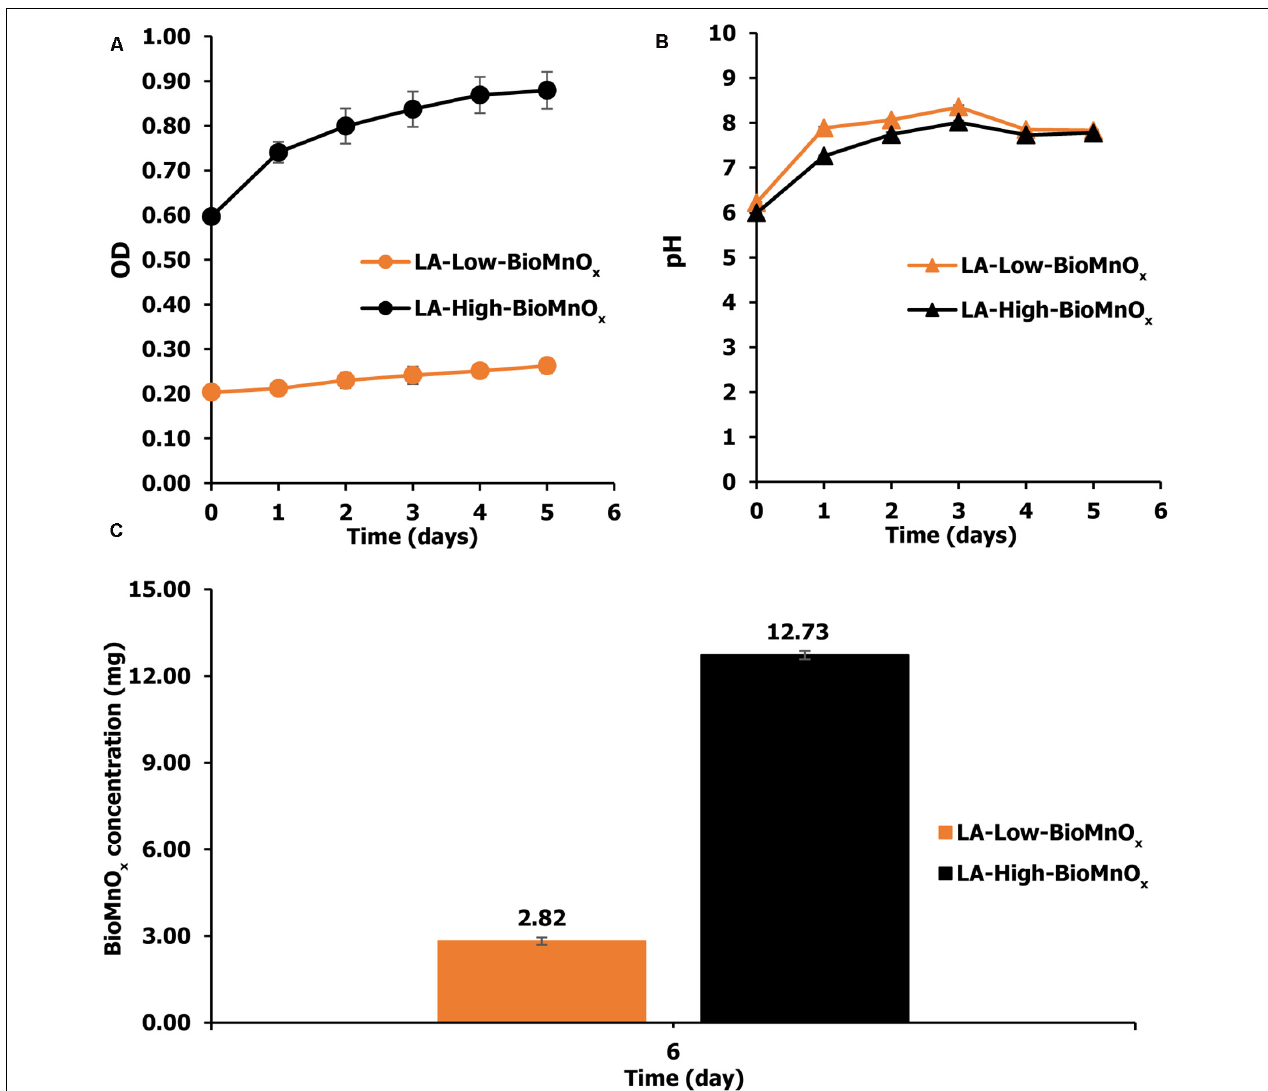
FIGURE 2 | (A) Optical density, (B) pH value, and (C) concentration of BioMnO x generated by P. duplex AARL G060. LA-Low-BioMnO x : living microalga with low BioMnO x and LA-High-BioMnO x : living microalga with high BioMnO x